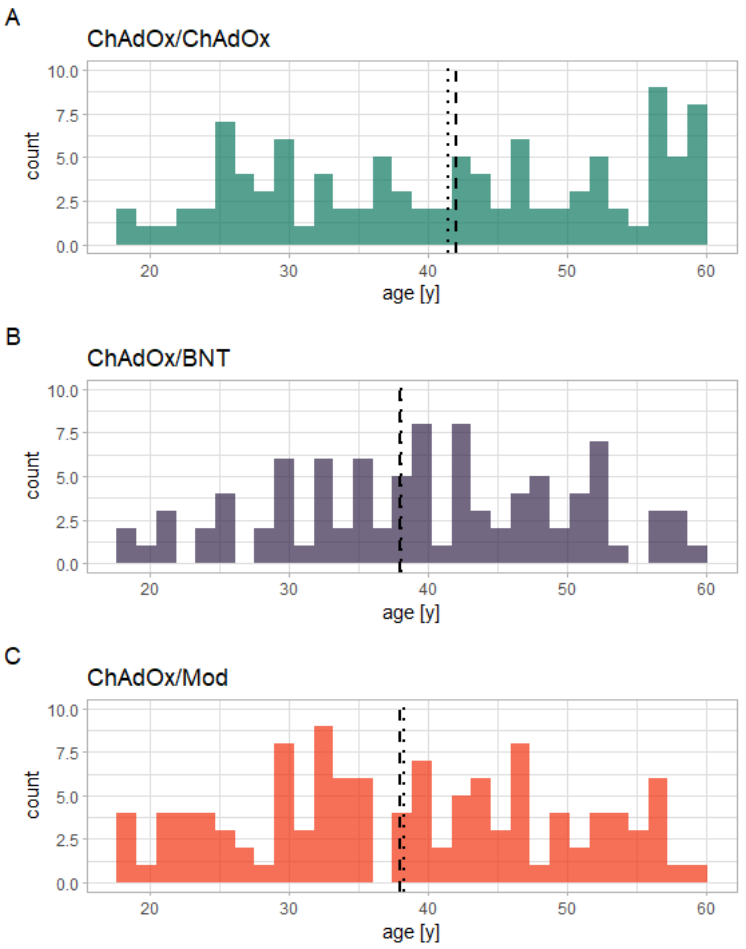
Figure 2. Histogram showing the different age distributions among participants receiving the three different vaccination regimens in the current study: ( A ) ChAdOx/ChAdOx; ( B ) ChAdOx/BNT; ( C ) ChAdOx/Mod). The dashed vertical lines mark the respective median, the dotted lines the mean.